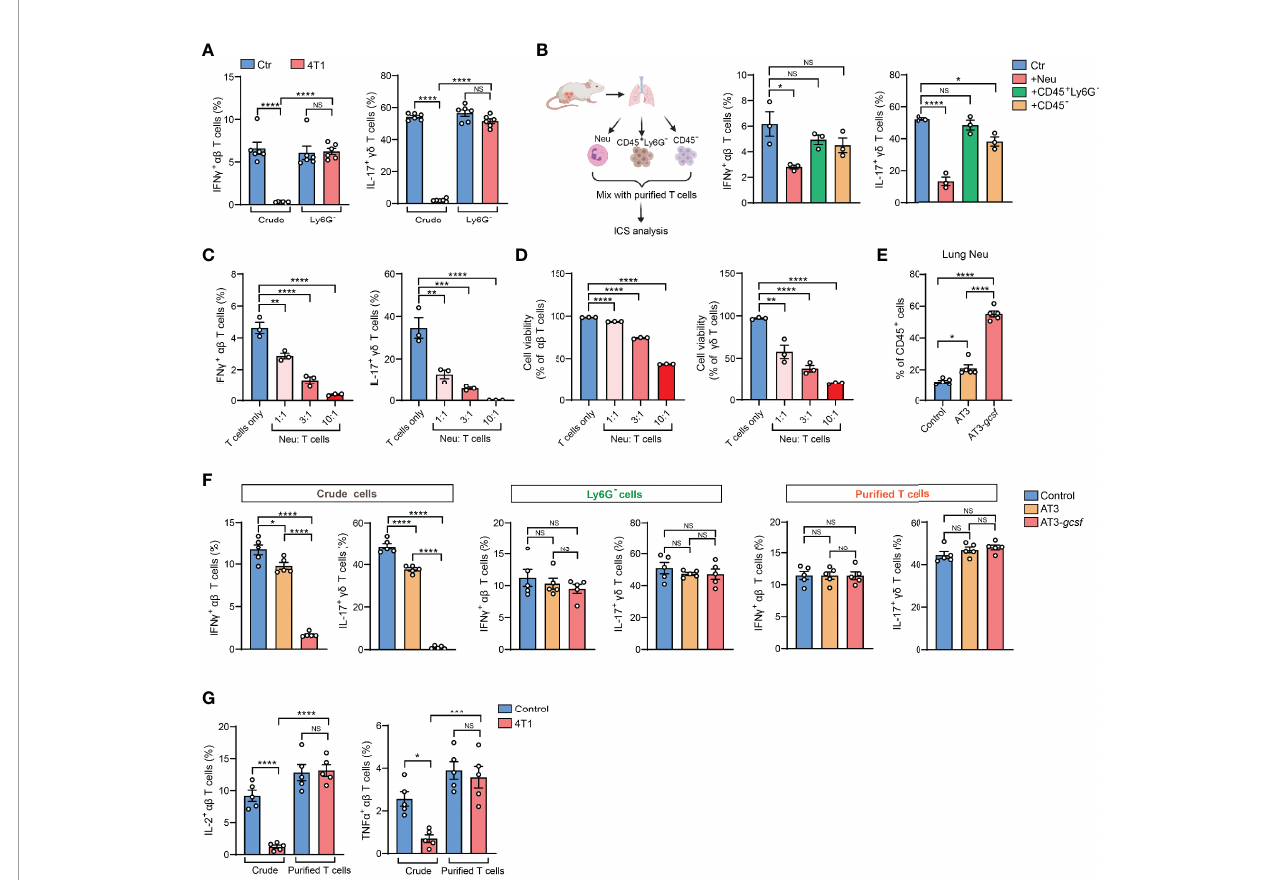
FIGURE 2 | Presence of neutrophils in crude tissue samples accounts for the artifactual results of T cell immunosuppression in tumor-bearing conditions. (A) ICS analysis of the frequencies of lung IFN g + ab T cells ( left ) or IL-17 + gd T cells ( right ) from control or 4T1 tumor-bearing mice (n=6 per group) with or without neutrophil depletion. (B) Puri fi ed naïve mice-derived lung T cells were mixed with different types of lung tissue cells (Ly6G + neutrophils, CD45 + Ly6G - non-neutrophil leukocytes, or CD45 - non-leukocyte stromal cells) derived from 4T1 tumor-bearing mice, and the frequencies of IFN g + ab T cells or IL-17 + gd T cells were quanti fi ed by ICS. (C, D) Puri fi ed naïve mice-derived lung T cells and 4T1 tumor-bearing mice-derived lung neutrophils were mixed together at the indicated ratios and subjected to ICS analysis. The frequencies of IFN g + ab T cells or IL-17 + gd T cells (C) were quanti fi ed, and the T cell viabilities (D) were determined by Live/Dead Fixable staining. (E) The percentages of lung neutrophils were compared among control, AT3- and AT3- gcsf tumor-bearing mice (n=5 mice per group). (F) ICS analysis of the frequencies of lung IFN g + ab T cells or IL-17 + gd T cells in crude samples ( left ), neutrophil-depleted samples (Ly6G - cells; middle ), and puri fi ed T cell samples ( right ) in the AT3/AT3- g-csf models (n=5 mice per group). (G) ICS analysis of the frequencies of lung IL-2 + ab T cells ( left ) or TNF a + ab T cells ( right ) in crude samples or in puri fi ed T cell samples from control or 4T1 tumor-bearing mice (n=5 per group). Values of n represent biologically independent animals. Data are mean ± s.e.m. P values were calculated using one-way ANOVA (A – G) . * P < 0.05; ** P < 0.01; *** P < 0.001; **** P < 0.0001. NS, not signi